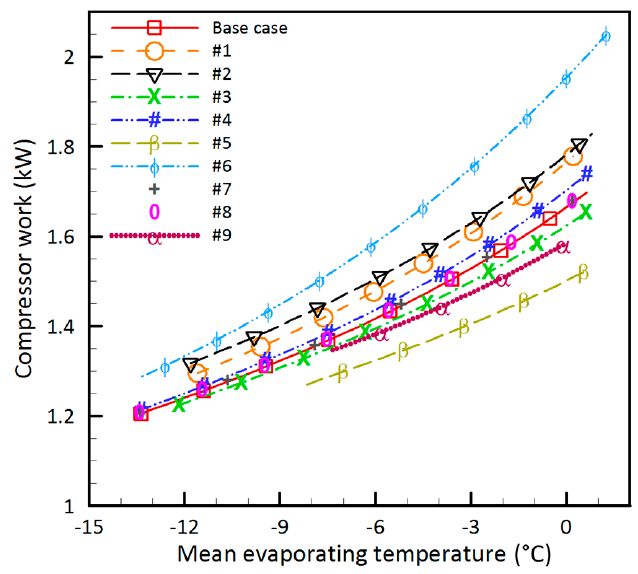
Figure 10. Compressor work ( W comp ). Energies 2018 , 11 , x FOR PEER REVIEW